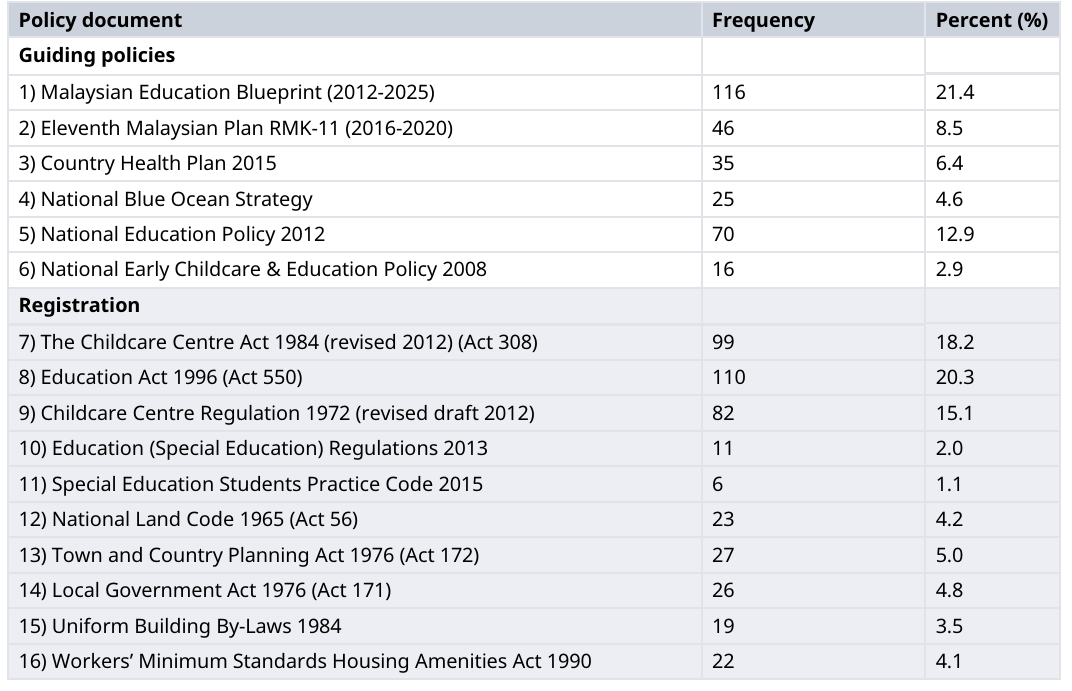
Table 2. Policy documents parents have referred to or